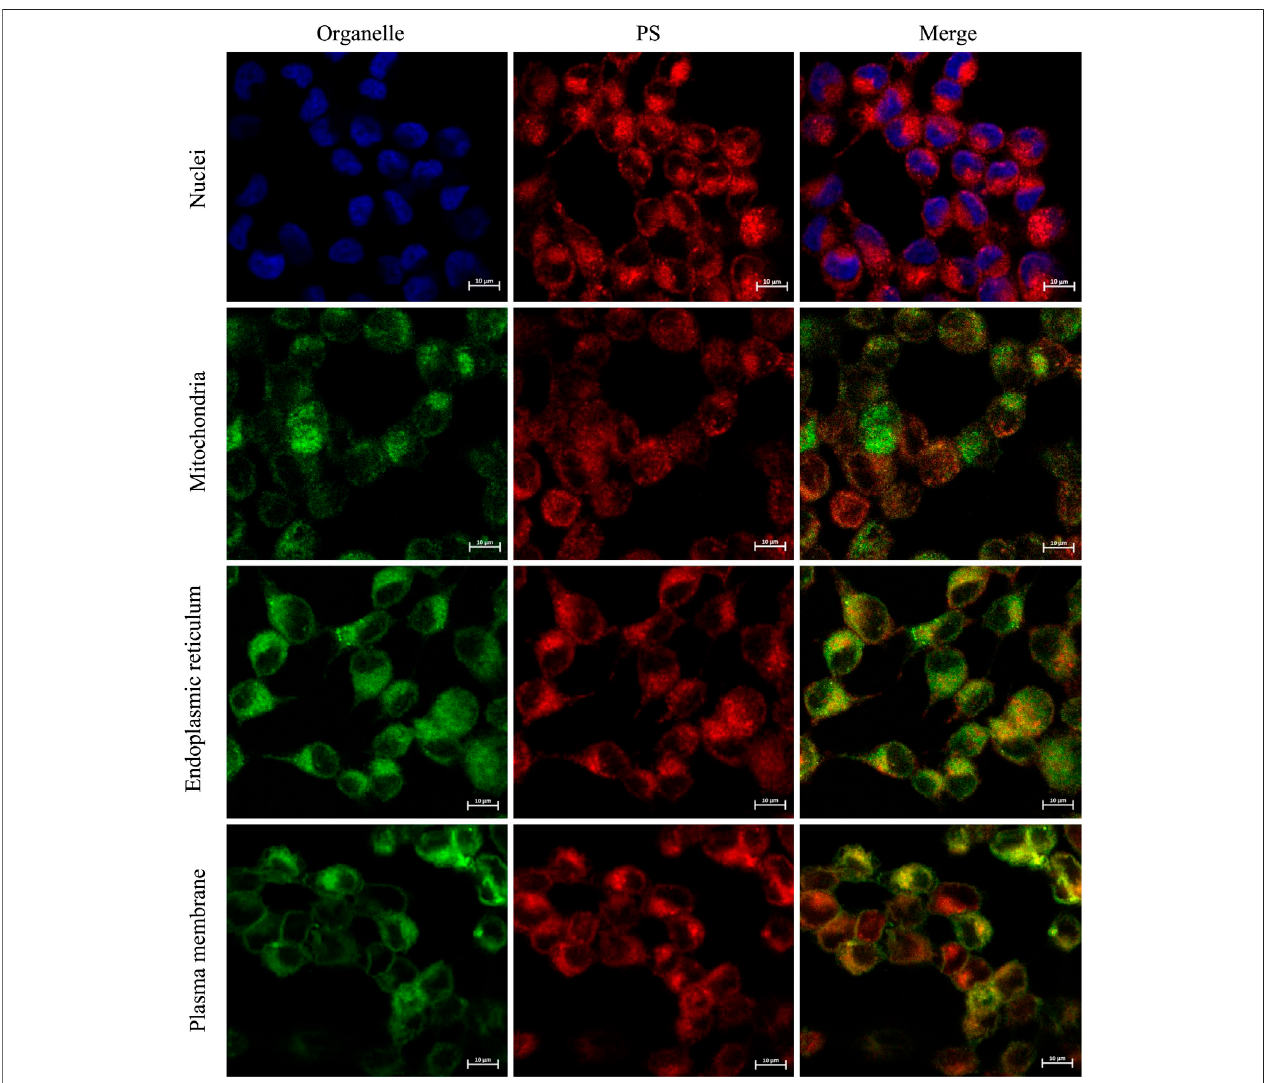
FIGURE 7 | Representative images of chlorin 5a colocalization in the nuclei, mitochondria, endoplasmic reticulum, and plasma membrane of human A375 skin malignantmelanomacells(foreachsetofimages,subcellularlocalizationoftheappropriatedprobe,ofchlorin 5a andthecorrespondingmergeimagesareshown).Cells were incubated with chlorin 5a in a concentration of 500 nM during 24